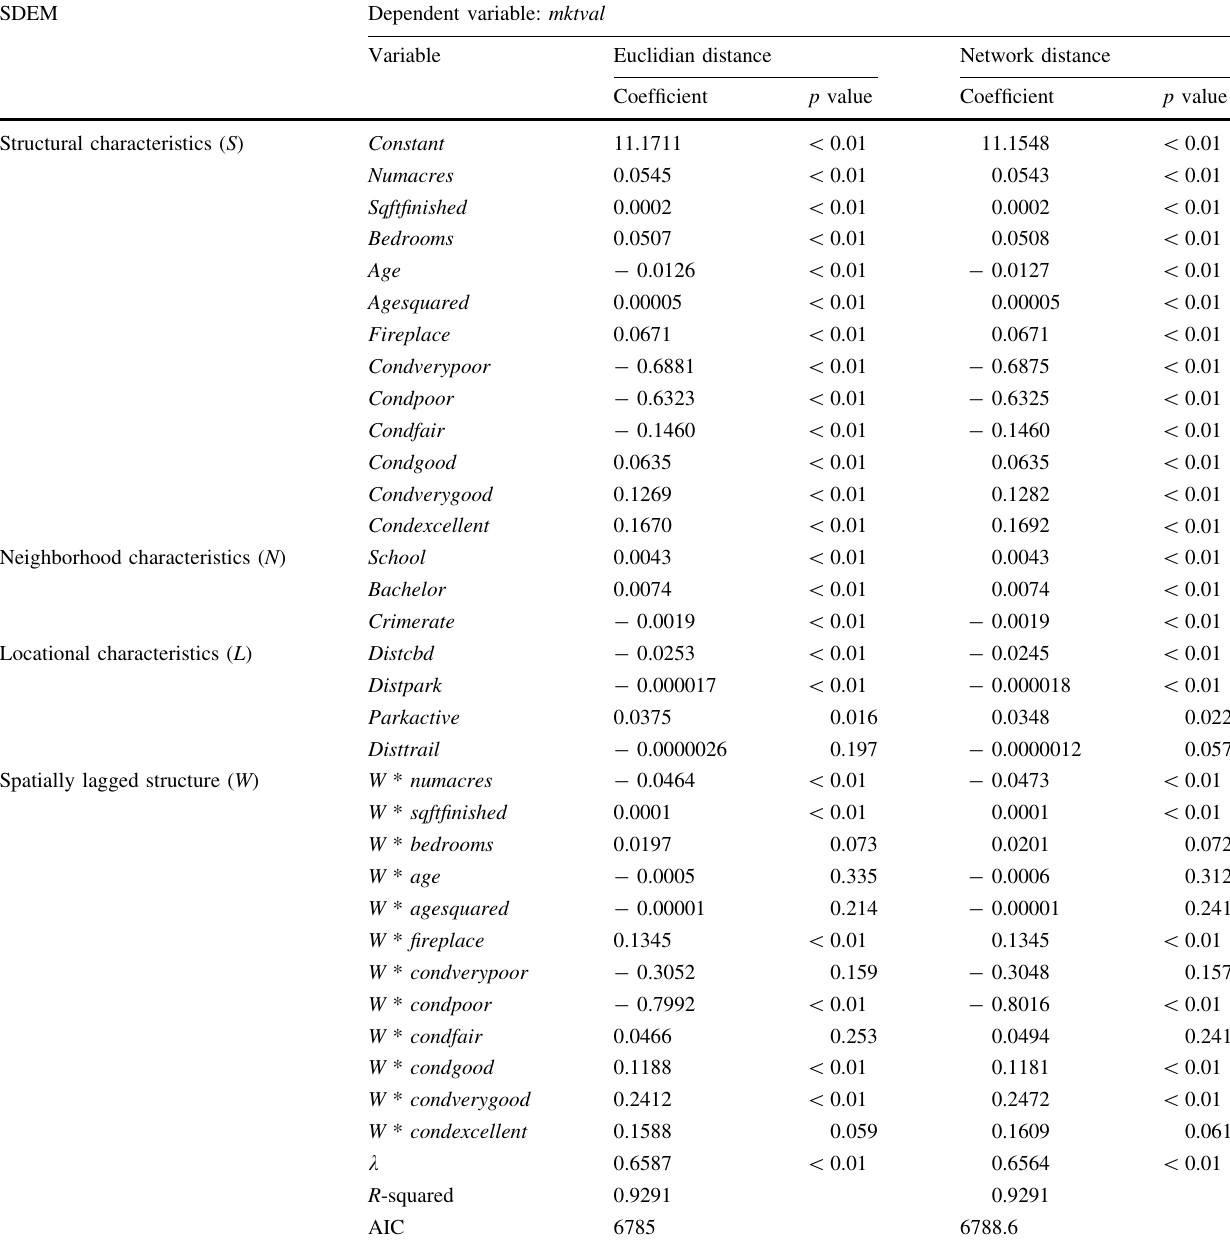
Table 3 Effects of the bike trail and parks on housing values in the SDEM